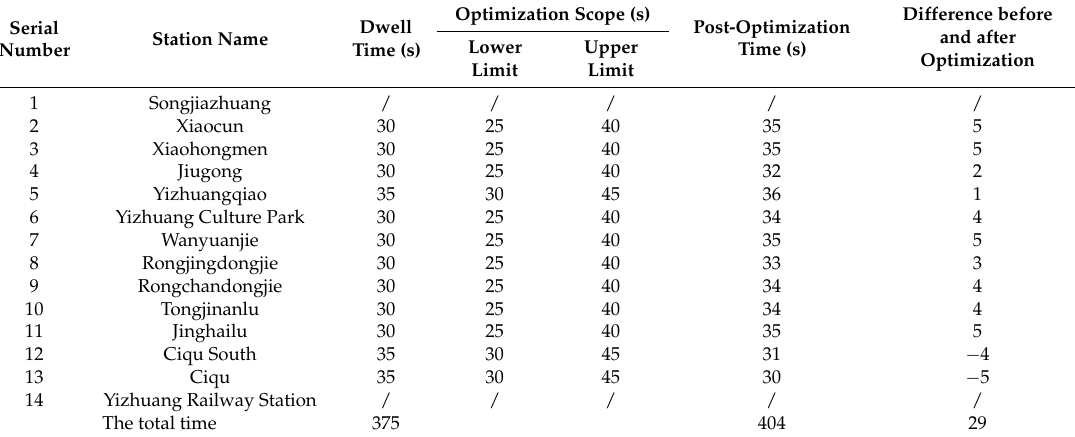
Table 5. Dwell time of Yizhuang subway line before and after optimization.